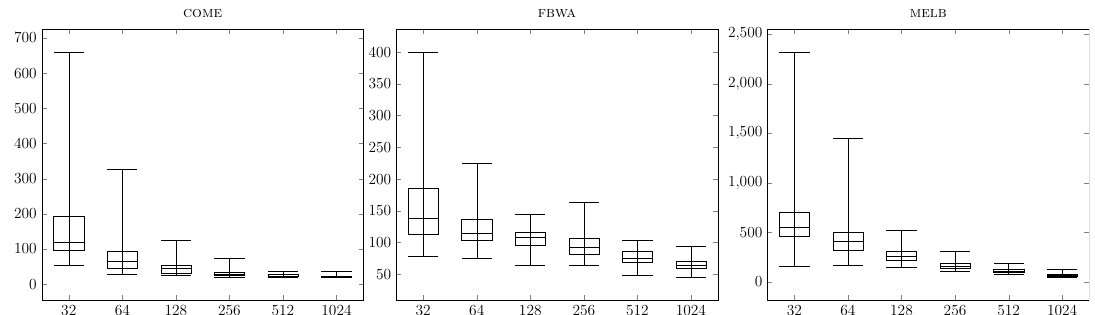
Figure 7. Box-and-whisker plots of the maximum position of top 20 nodes in the approximate ranking as a function of the sample size in the case of the temporal graphs COME , FBWA , and MELB . Table 2. Maximum position of the top- k nodes (for the exact ranking) in the approximate ranking computed by APX - h (over 50 experiments) in the case of the temporal graphs included in our sample dataset (excluding TWIT for which the exact ranking could not be